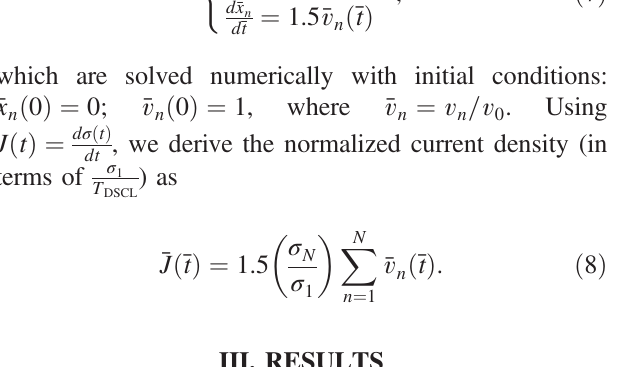
FIG. 2. The trajectories of each beam [(a), (b) and (c)] and current density [(d), (e) and (f)] in a drift space with gap spacing d ¼ 5 ½ cm (cid:2) and injected kinetic energy 50 [keV] for N ¼ 30 and Δ ¼ 2 . 16 ½ ps (cid:2) at σ ¼ σ [(a) and (d)], σ ¼ 0 . 7 σ [(b) t N ¼ 175 N ¼ 175 and (e)] and σ ¼ 0 . 1 σ [(c) and (f)]. The last 2 figures: (g) N ¼ 175 and (h) are the magnification of (b) and (c), respectively in region near to x ¼ 1 . In the figure, the normalized parameters are ¯ J ≡ J defined as ¯ x ≡ x , ¯ t ≡ t and σ 1 =T d T DSCL DSCL